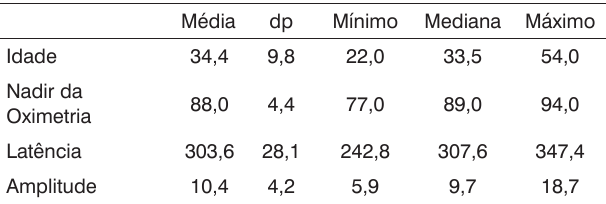
Tabela 3. Grupo controle: média, desvio padrão, valores mí- nimo, máximo e mediana, para a idade, nadir da oximetria, e latência/amplitude do P 300 (N=12).